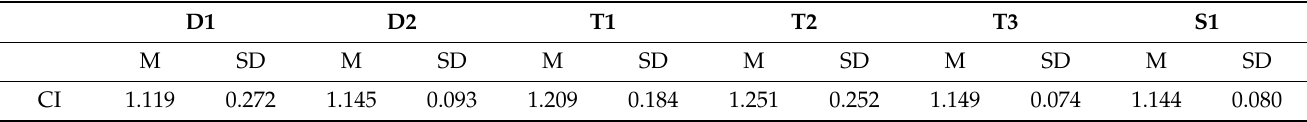
Table 4. Average and standard deviation values for conformity indices across all plans and partici- pants. Conformity indices were calculated according to RTOG protocol using the 95% isodose line as the reference